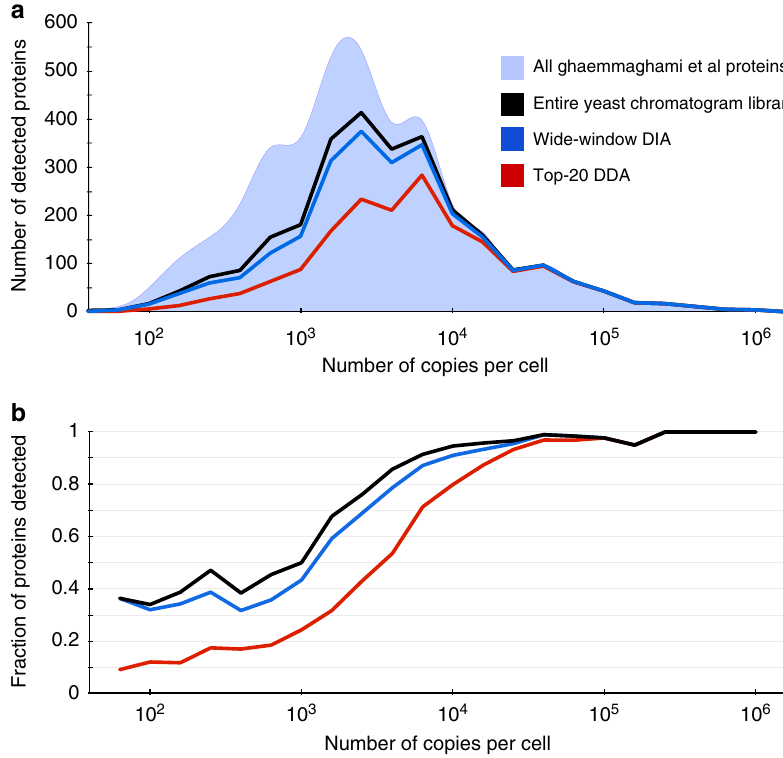
Fig. 3 Protein detection rates scale with abundance. The a number and b fraction of proteins detected in yeast at different orders of magnitude of abundance. Ghaemmaghami et al comprehensively estimated protein copies per cell in yeast (light blue area, 3868 total proteins) using high-af fi nity epitope tagging. While top-20 DDA (red line, 1798 total proteins) can measure some low abundant proteins at 1% protein-level FDR, the strategy only detected 48% of mid-range proteins with estimated copies per cell between 10 3 and 10 4 . In contrast, at 1% protein-level FDR, wide-window DIA using a Walnut-based chromatogram library (blue line, 2519 total proteins) detected 71% of these proteins and overall recapitulated 91% of proteins found in the entire Walnut-based chromatogram library (black line, 2754 total